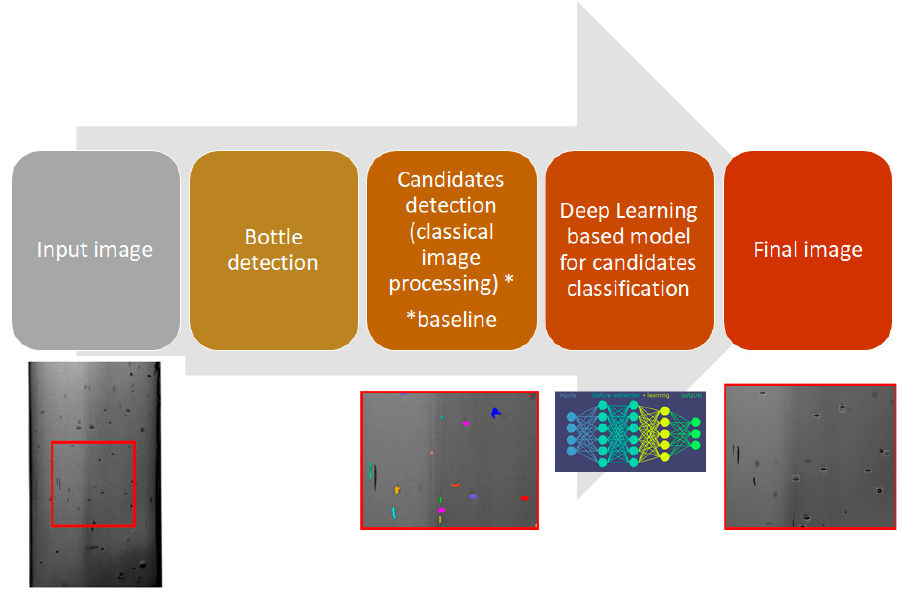
Figure 3. Processing pipeline.